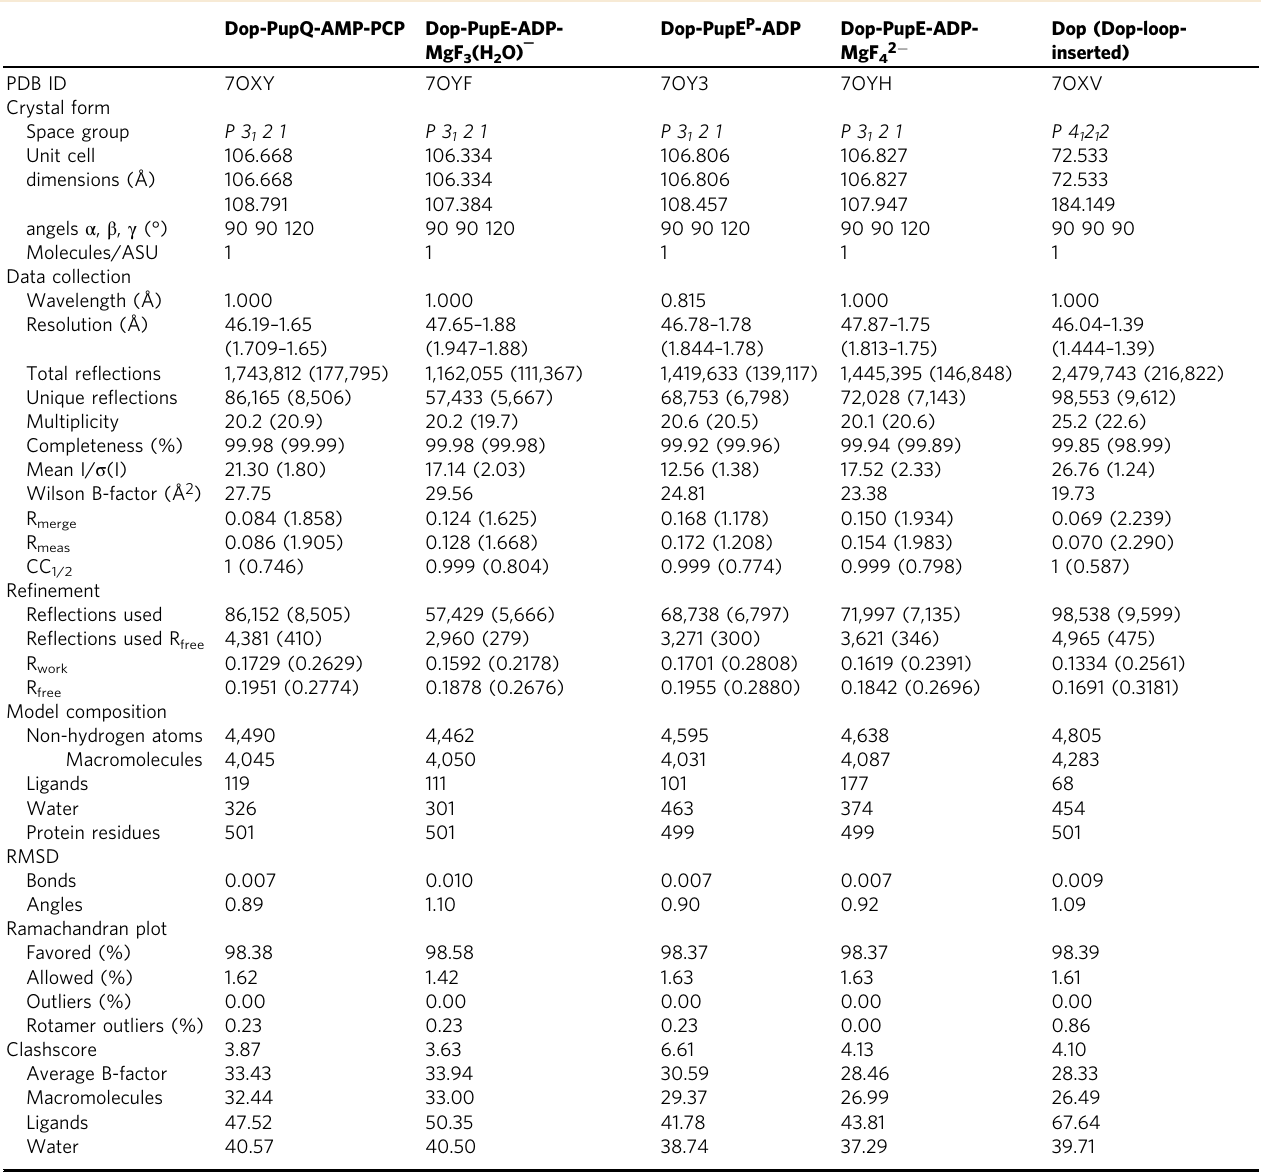
Table 1 Data collection and re fi nement